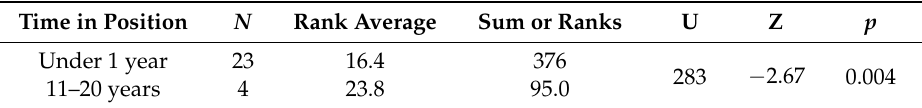
Table A1. Mann-Whitney test results for time in position and hazard recognition accuracy.